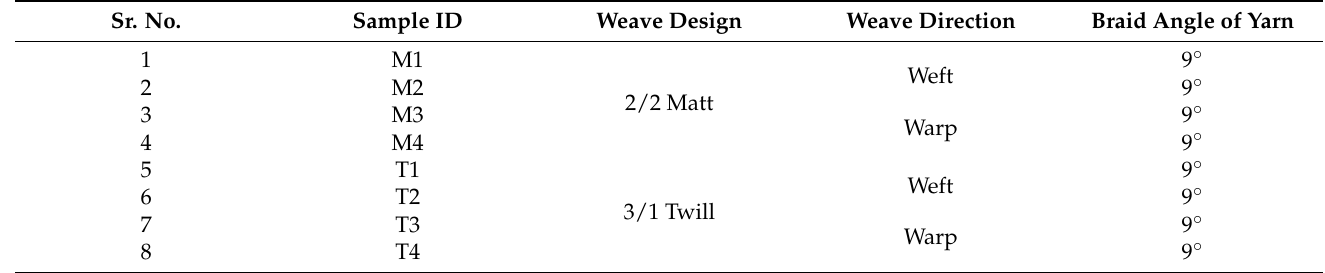
Table 2. Sample identification for woven fabric with different geometrical